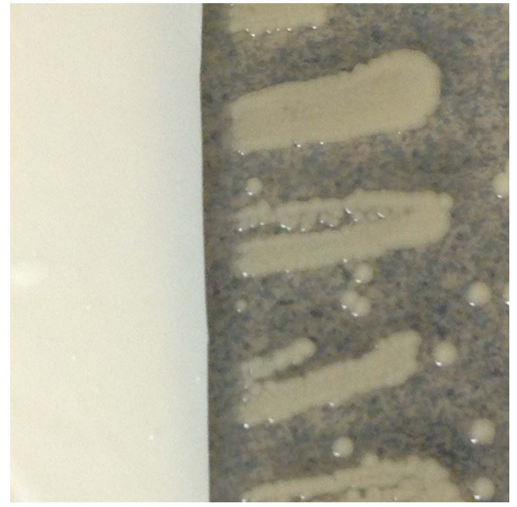
Figure 3. Typical results, latex gloves with inhibition of Klebsiellapneumoniae